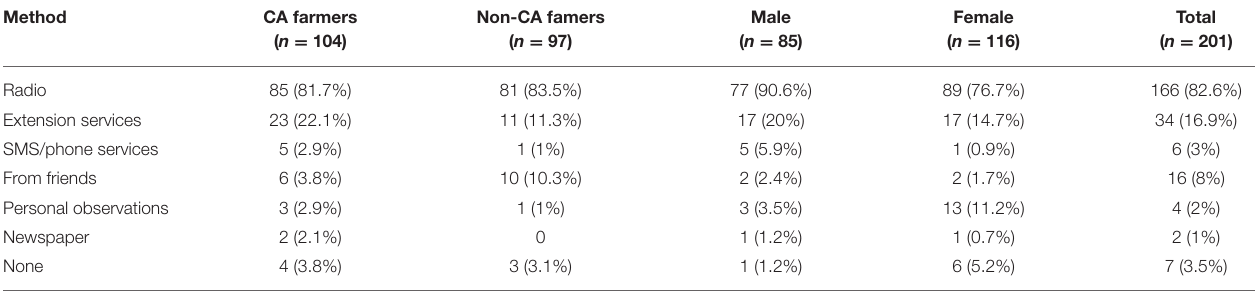
TABLE 2 | Sources of weather information [multiple answers accepted (Household survey n =